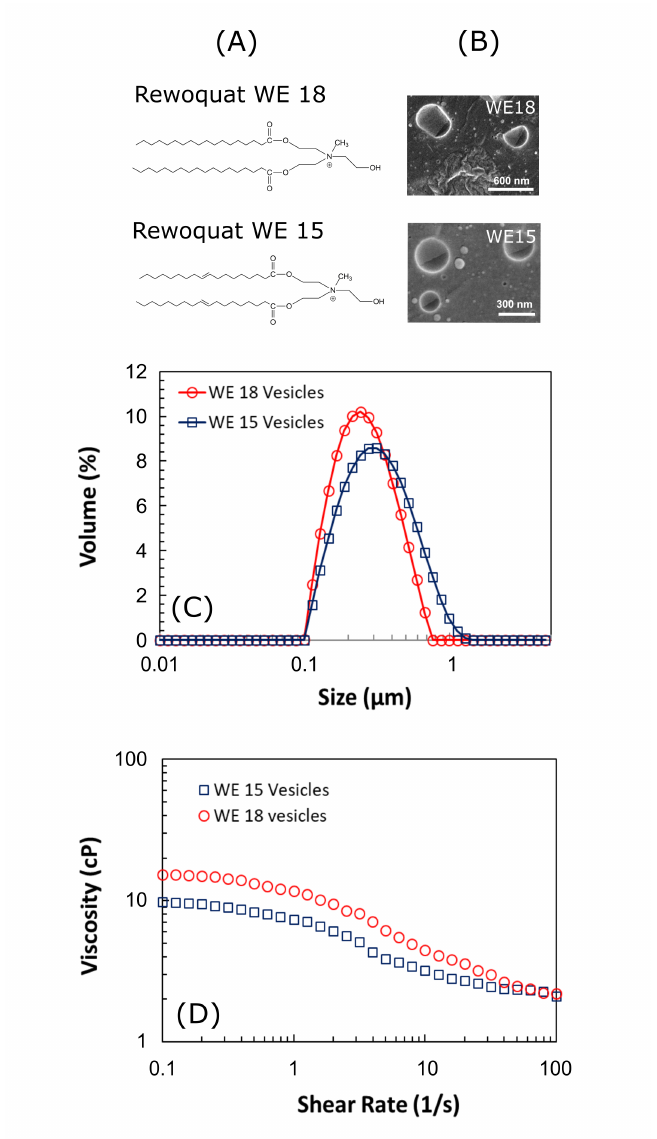
Figure 4. ( A ) Chemical structures of the lipids Rewoquat WE18 and WE15; ( B ) Cryo-electron microscopy (EM) images of WE18 and WE15 vesicles; ( C ) Particle size distributions of WE18 and WE15 vesicles; ( D ) Variation of the viscosity of WE18 and WE15 vesicle dispersions with shear